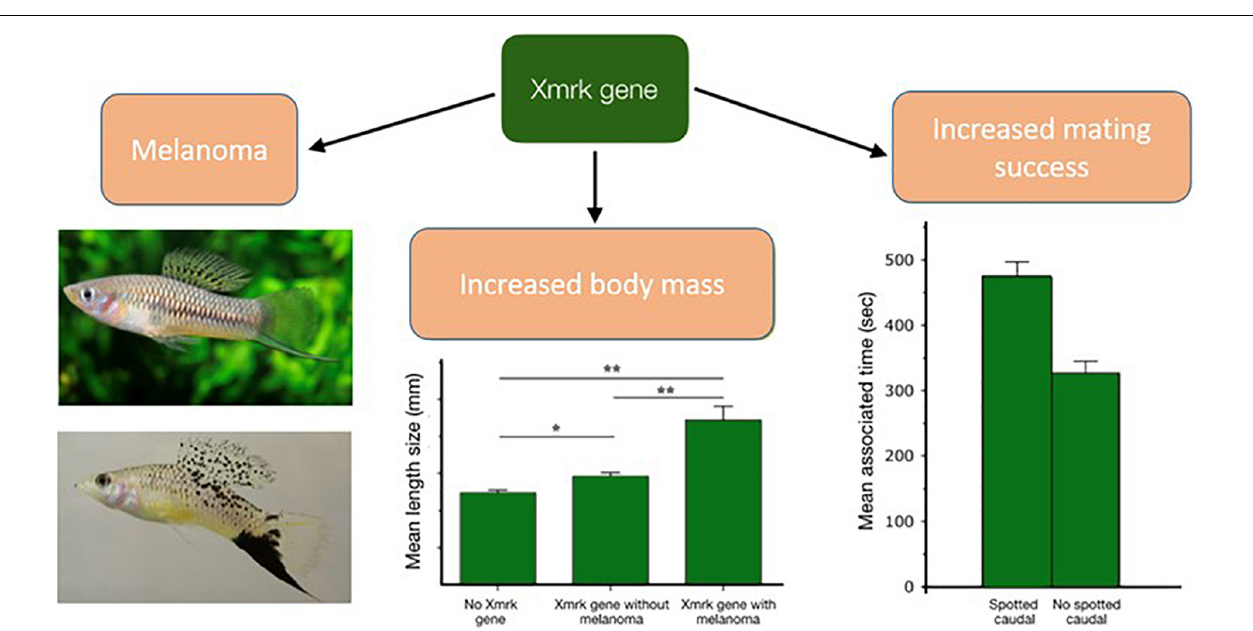
FIGURE 2 | Antagonistic pleiotropy and oncogenic congenital mutations: the Xmrk melanoma-promoting oncogene in the fish Xiphophorus cortezi. Sexual selection processes may sometimes favor cancer promoting oncogene alleles, as this is observed in the fish Xiphophorus developing melanoma (bottom Photo). Despite shorter lifespan due to the deleterious cancer-induced effects, the oncogenic Xmrk allele is not eliminated from natural populations of Xiphophorus , because several associated benefits early in life outweigh late costs (i.e., antagonistic pleiotropy). Xmrk allele is indeed associated to a larger body size and higher aggression, which increases individual’s reproductive success through mate choice and competition for mates. The source and credit for the fish photos: Johnny Jensen (up) and Andre Fernandez (down). Figure modified from Fernandez and Morris (2008). * P < 0.05, ** P <